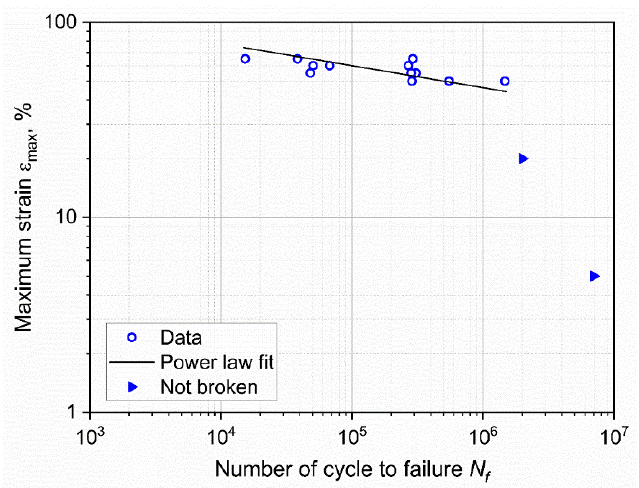
Figure 3. Wöhler curve obtained from axisymmetric dumbbell specimens of CB filled NBR at a frequency of 4 Hz and a load ratio R ε of 0.5. The fitting power law (Equation (1)) was obtained using ASTM E739–10.